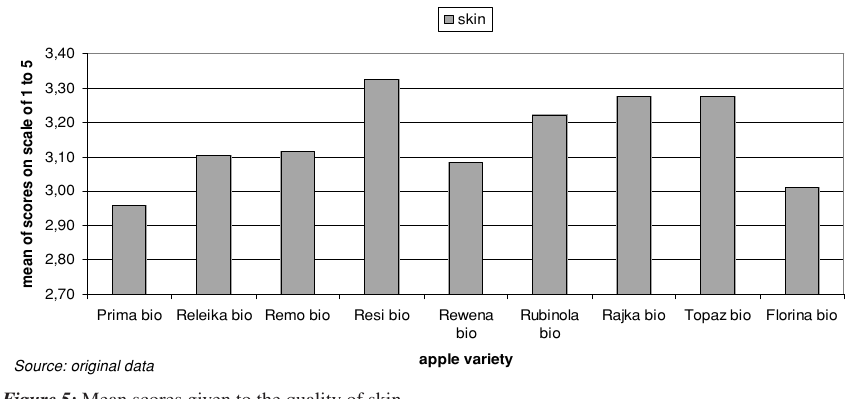
Figure 5: Mean scores given to the quality of skin